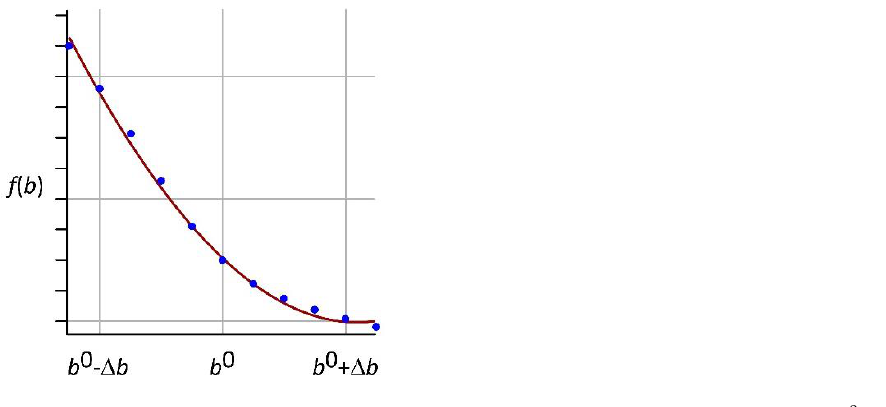
Figure 2. Graphical representation of the response function method for n = 11 and Δ b / b 0 = 0.05 (blue points — discrete data, red curve — approximation).